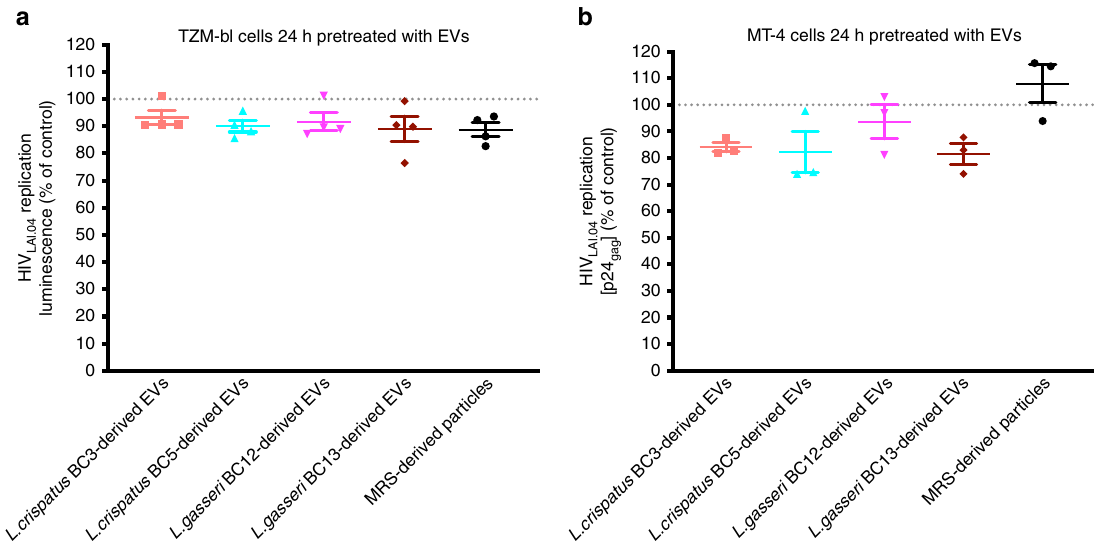
Fig. 7 HIV-1 infection in cells pretreated with Lactobacillus -derived EVs. To study whether bacterial EVs alter host cell function to induce protection against HIV-1, TZM-bl or MT-4 cells were treated with bacterial EVs derived from L. crispatus BC3, L. crispatus BC5, L. gasseri BC12, L. gasseri BC13, or MRS- isolated particles for 24 h, prior to HIV-1 infection, and then HIV-1 infectivity was evaluated. a To measure HIV-1 LAI.04 integration in TZM-bl cells, we removed the cell culture medium, lysed the cells, added substrate, and measured the luminescence. b To measure HIV-1 LAI.04 replication in MT-4 cells the levels of HIV-1 p24 gag protein in cell culture were measured with Luminex. Presented are means ± SEM from at least three independent measurements. Source data are provided as a Source Data fi MRS-derived particles ( p = 0.7353, n = 3, repeated-measures ANOVA) (Fig. 7b).